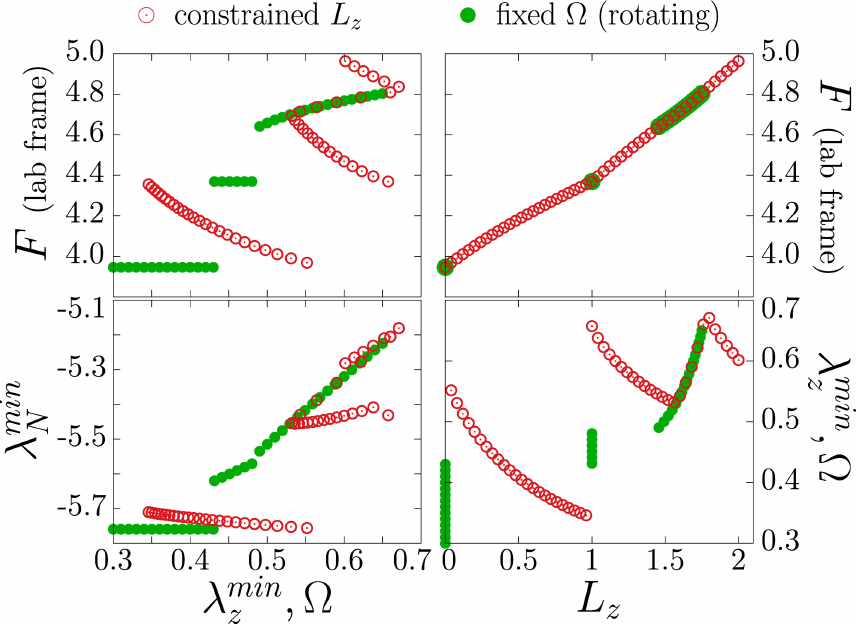
Figure 4 . Detailed comparison of the solutions to the two equations (B.4) for g = 100 . The panels on the top row display the energy, in a non-rotating frame, as a function of angular velocity Ω (left) and value of angular momentum L z (right). The empty (red) circles denote the results from the constrained minimization at given value of the angular momentum L z . The filled (green) circles show the results from the minimization of a rotated condensate at given angular velocity Ω